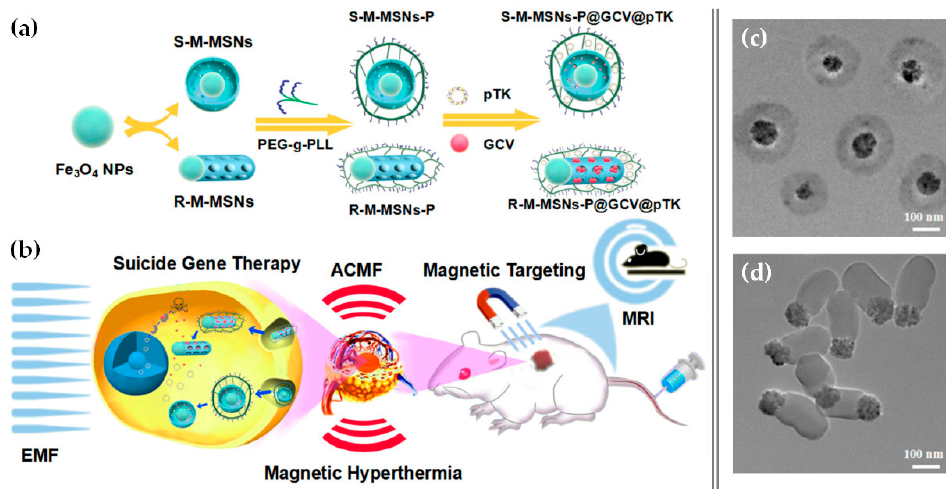
Figure 17. Schematic illustration of ( a ) the preparation of differently shaped magnetic-MSNs with a polymer (PEG- g -PLL) coating for herpes simplex virus thymidine kinase/ganciclovir (HSV-TK/GCV) gene therapy, ( b ) application of the nanosystem for MRI-guided, magnetically targeted and